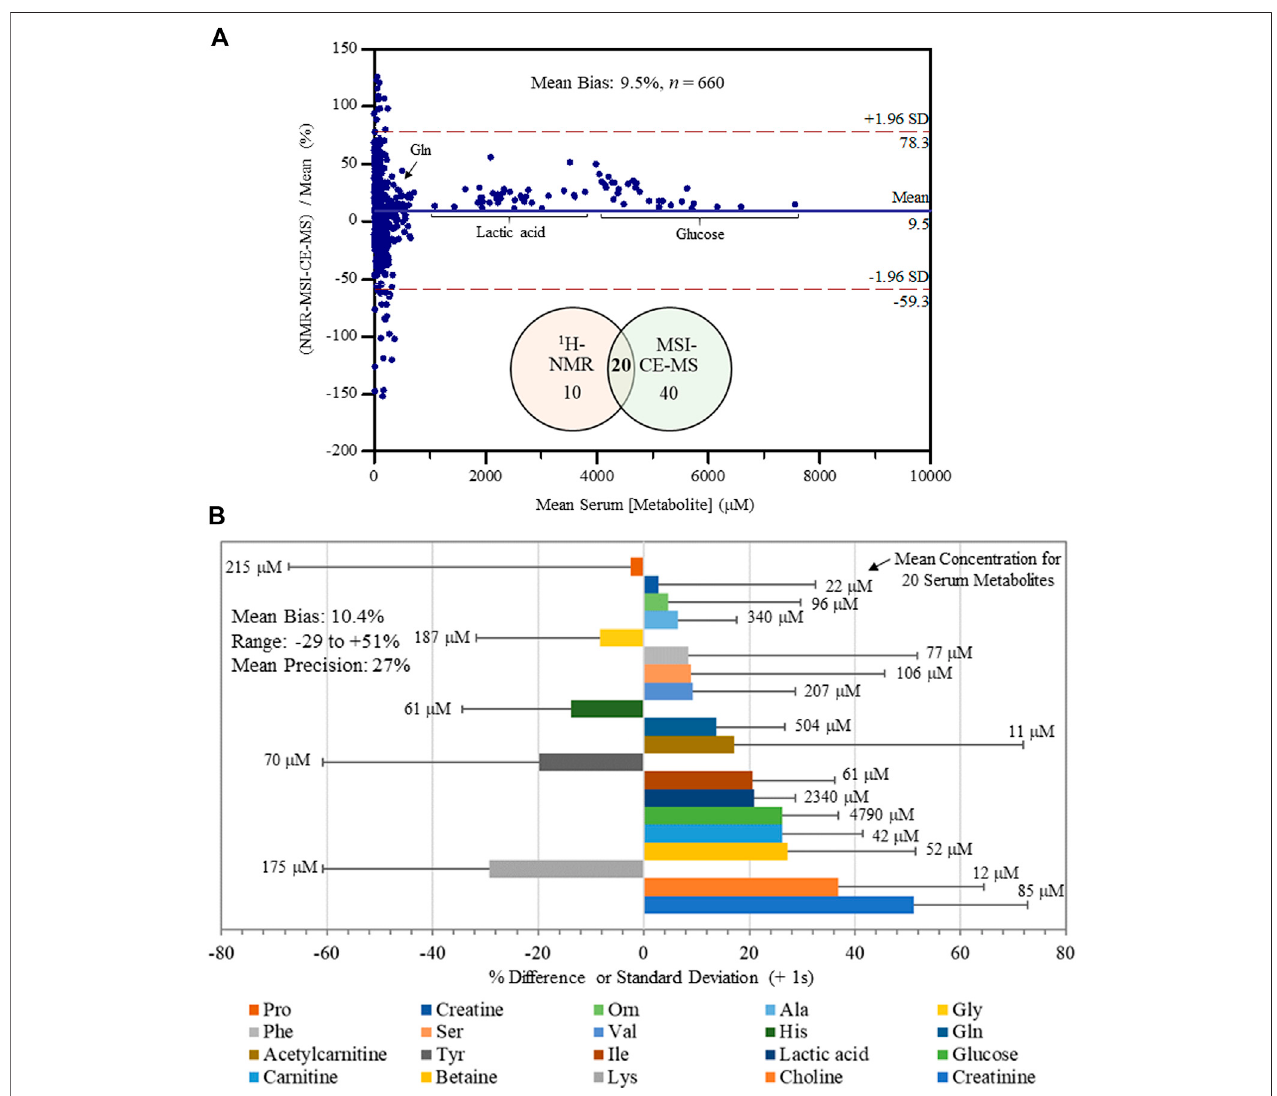
FIGURE 3 | Inter-method comparison for serum metabolite quanti fi cation by 1 H-NMR and MSI-CE-MS platforms in non-HCV and HCV patients ( n (cid:1) 34). (A) A Bland-Altman %difference plot con fi rms a normal distribution for 20 serum metabolite concentrations measured independently in 34 serum fi ltrate samples having a mean bias of 9.5% ( n (cid:1) 660) with few metabolites ( ∼ 5%) exceeding mutual agreement limits ( ± 2s). (B) A summary of the mean concentration ( μ M) for each serum metaboliteconsistentlymeasuredbybothinstrumentalplatforms,aswellasabargraphdepictingthemeanbias(%difference)togetherwithanerrorbarindicating the mean precision (+1 s) in reported bias across all samples ( n (cid:1) 34). Serum metabolites analyzed in this study were ranked ordered (top to bottom) from lowest to highest bias having an overall bias and precision of 10.4 and 27%,